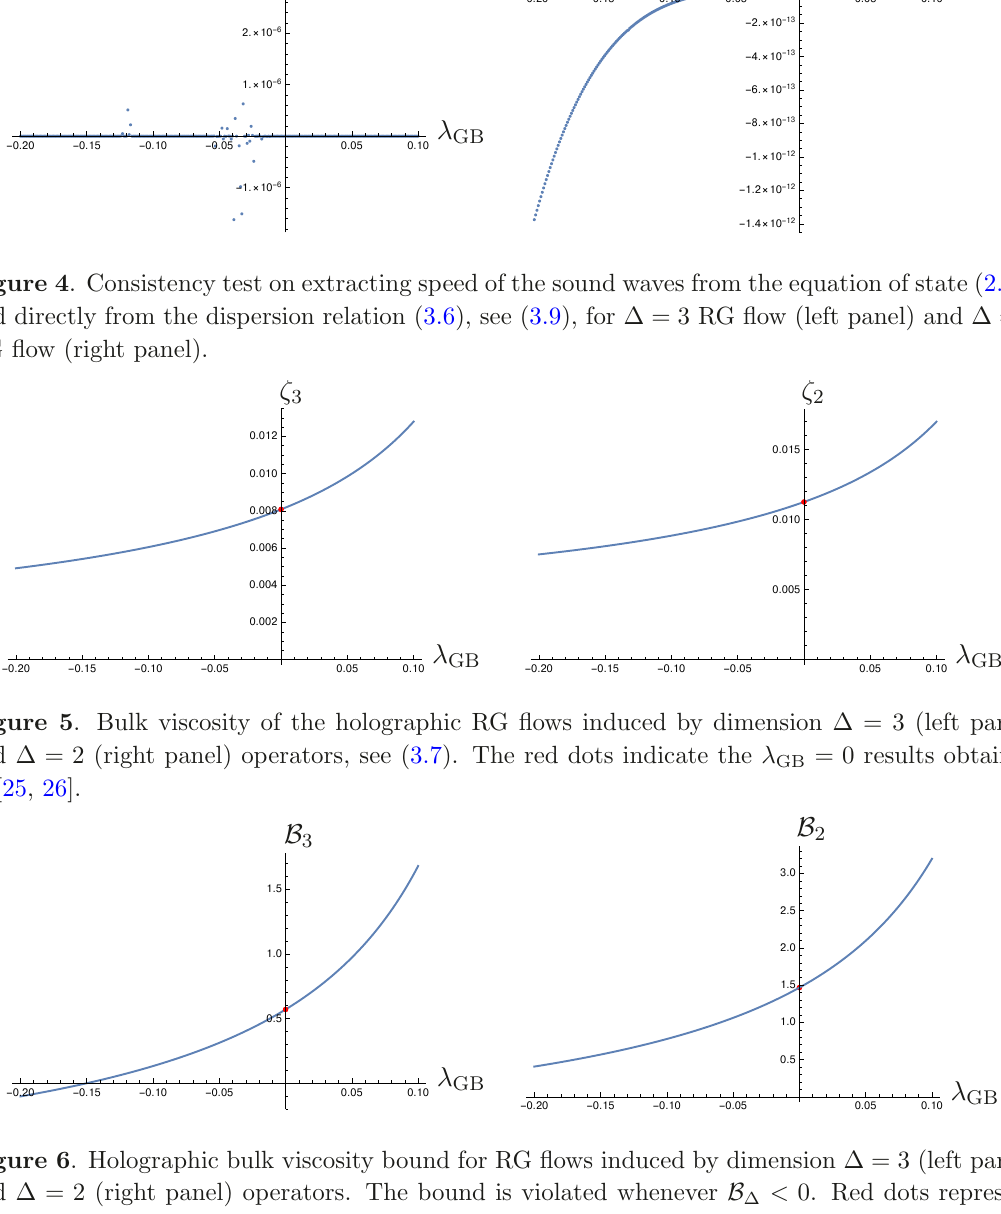
∆ < 0. Red dots represent B